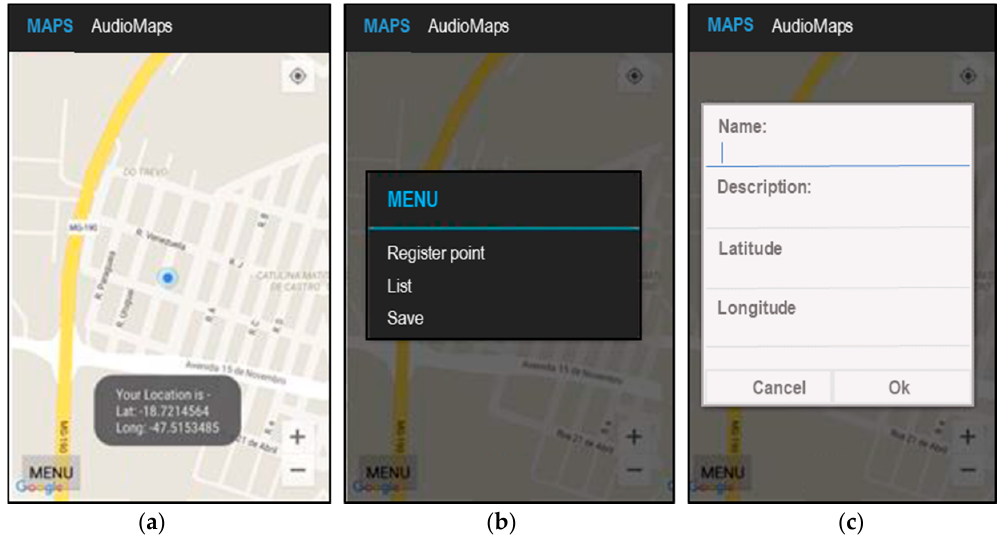
Figure 2. AudioMaps interfaces: ( a ) initial (real-time location); ( b ) tools (point registration, visualization, and storage); ( c ) point registration description.